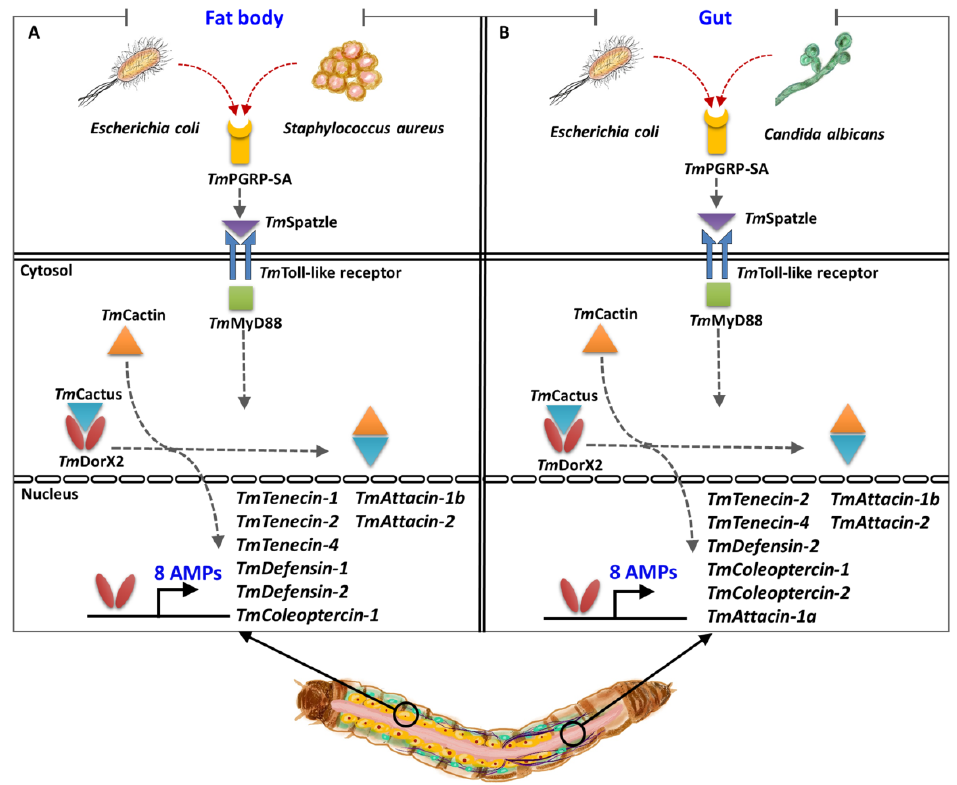
Figure9. Asimplifiedschematicrepresentationofthekeyroleof Tm PGRP-SAinregulatingantimicrobial peptide (AMP) expression in the larval fat body ( A ) and gut ( B ) following infection with E. coli , S. aureus , and C. albicans